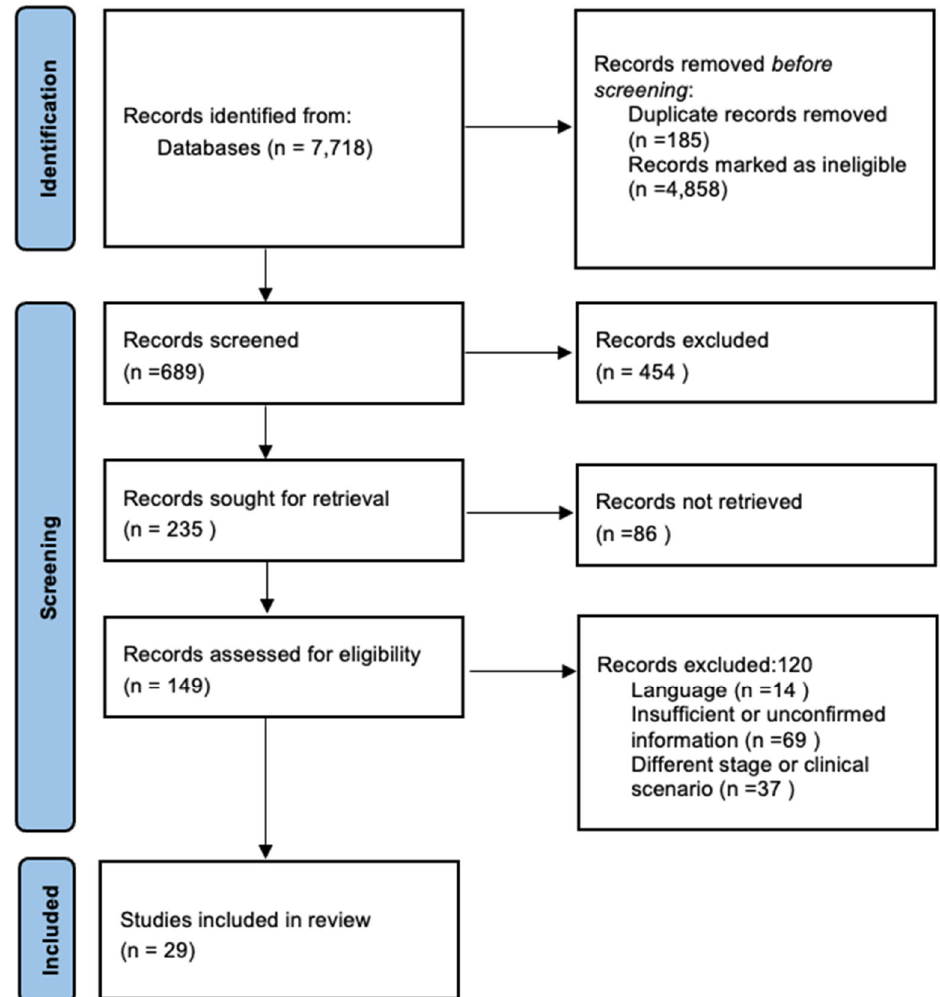
Figure 1. Evidence acquisition according to the PRISMA diagram.